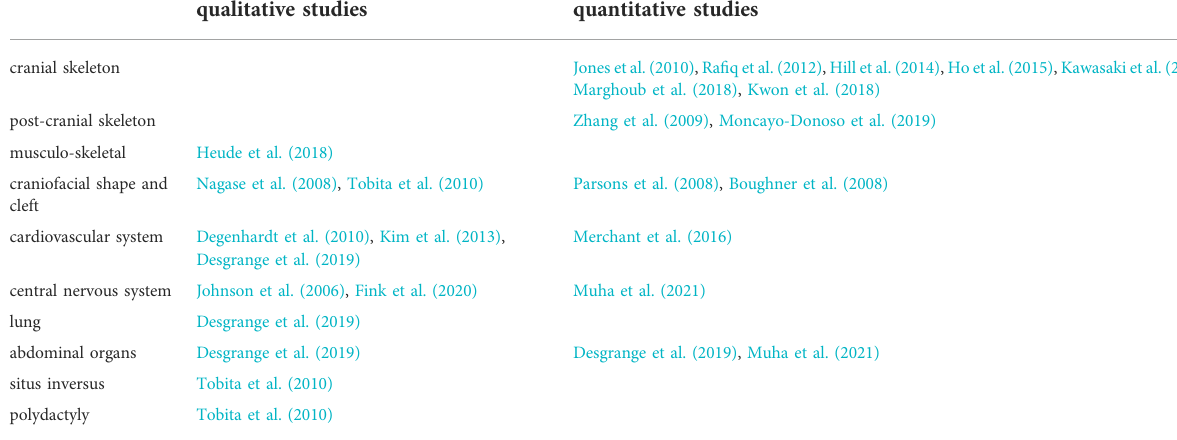
TABLE 1 Overview of microCT studies investigating disorders in mouse organ